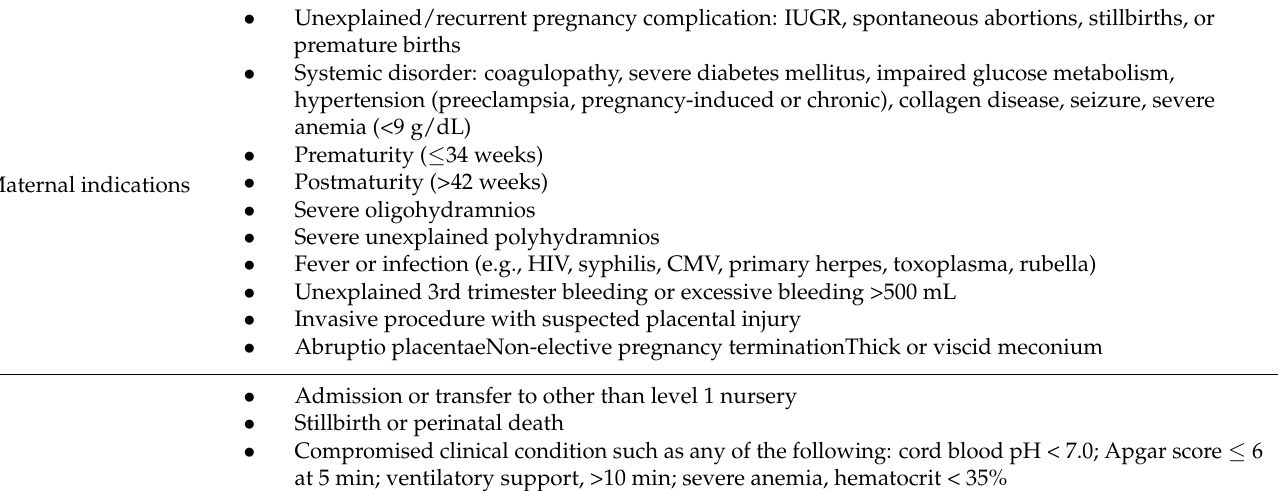
Table 1. Clinical indications for the pathologic examination of the placenta, as set by the CAP 1997